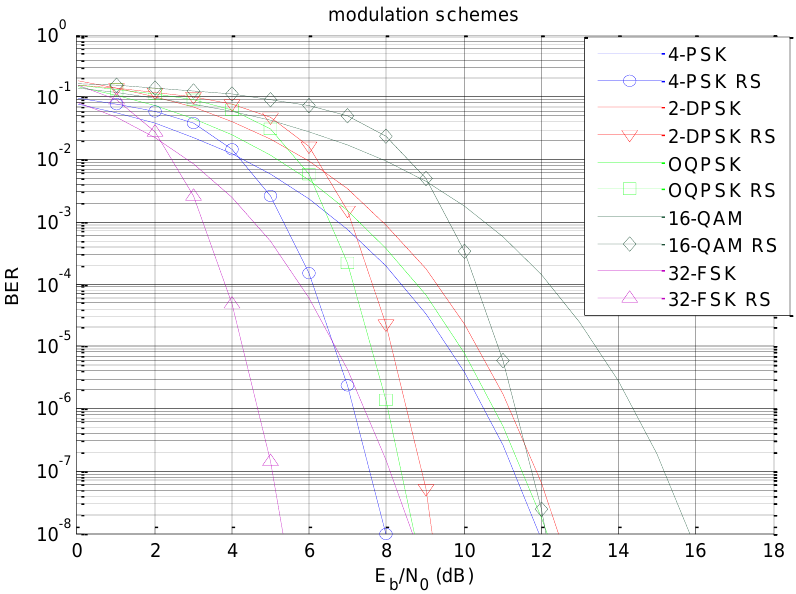
Figure 13. RS error performance for difference modulation